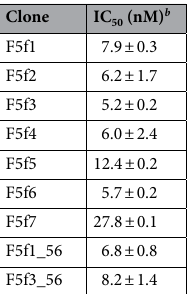
Table 1. Aptamer inhibition of NIH3T3 cell proliferation a . a The data of the cell proliferation assay are shown in Fig. 2. b IC 50 is represented by the mean ± standard error from three independent